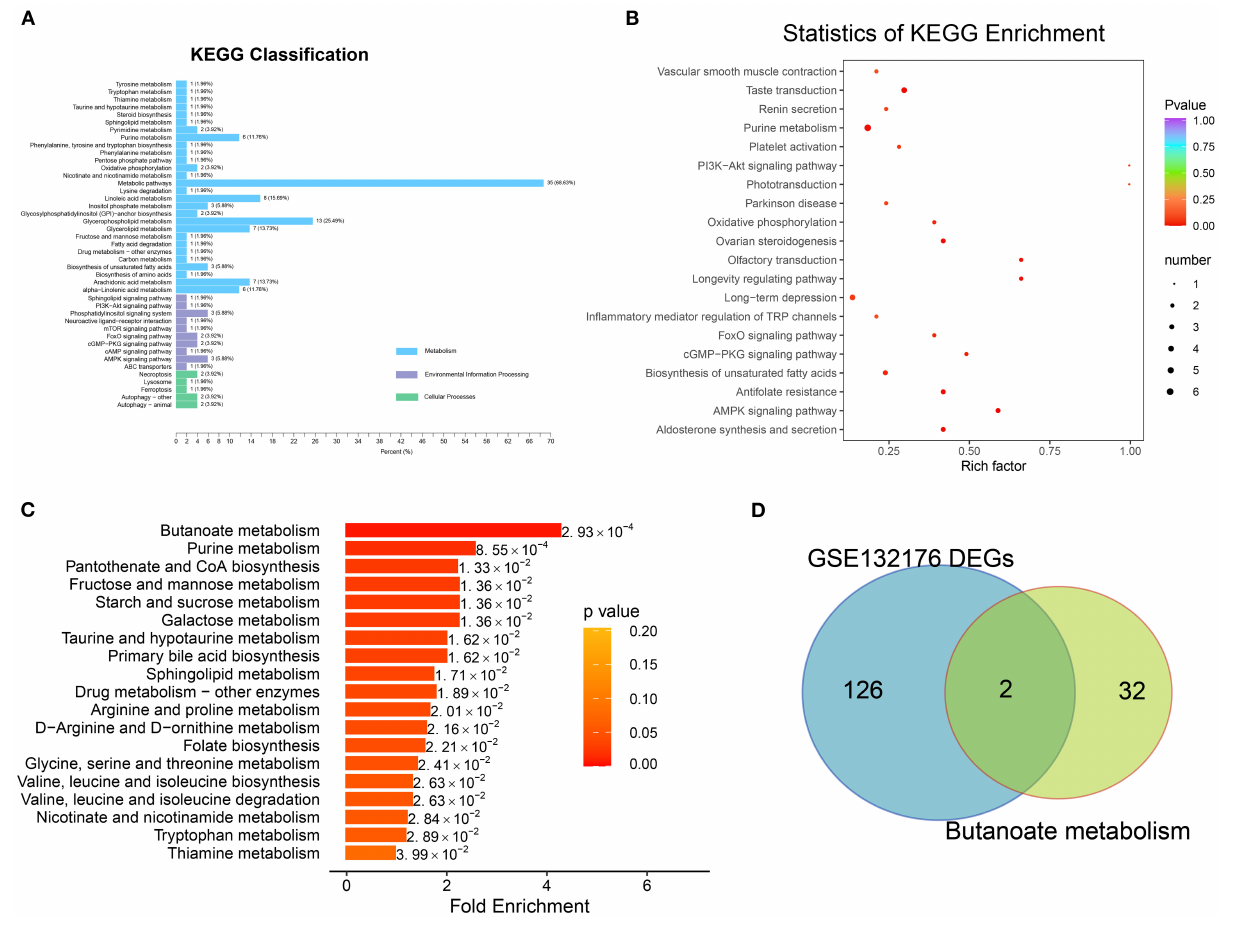
FIGURE 5 | Pathway enrichment analysis with differentially expressed metabolites. (A) The Kyoto Encyclopedia of Genes and Genomes (KEGG) pathway analysis involved in classification of environmental information processing, metabolism, and cellular processes were identified. (B) Of the biologic procession, the significantly enriched terms were identified in Figure 4B . (C) Metabolic pathway enrichment was detected based on metabolite set enrichment analysis. (D) Overlap between the gene list involved in butanoate metabolism and DEGs of